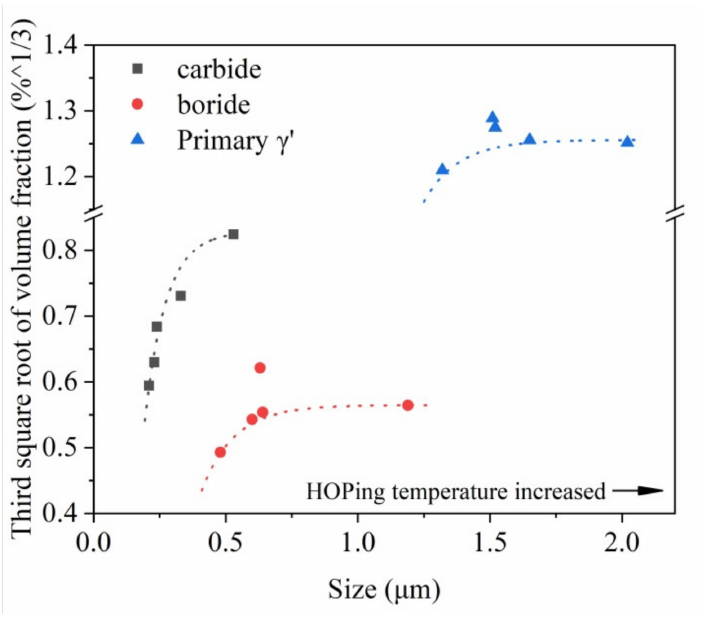
Figure 14. The relationship between size and volume fraction of PPBs